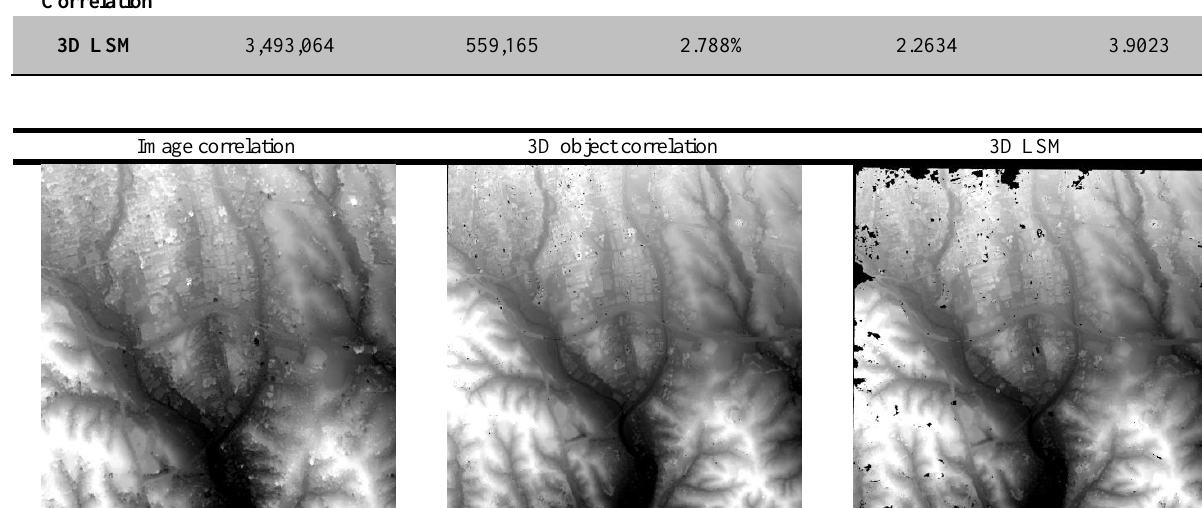
Figure 4. Generated DEM images